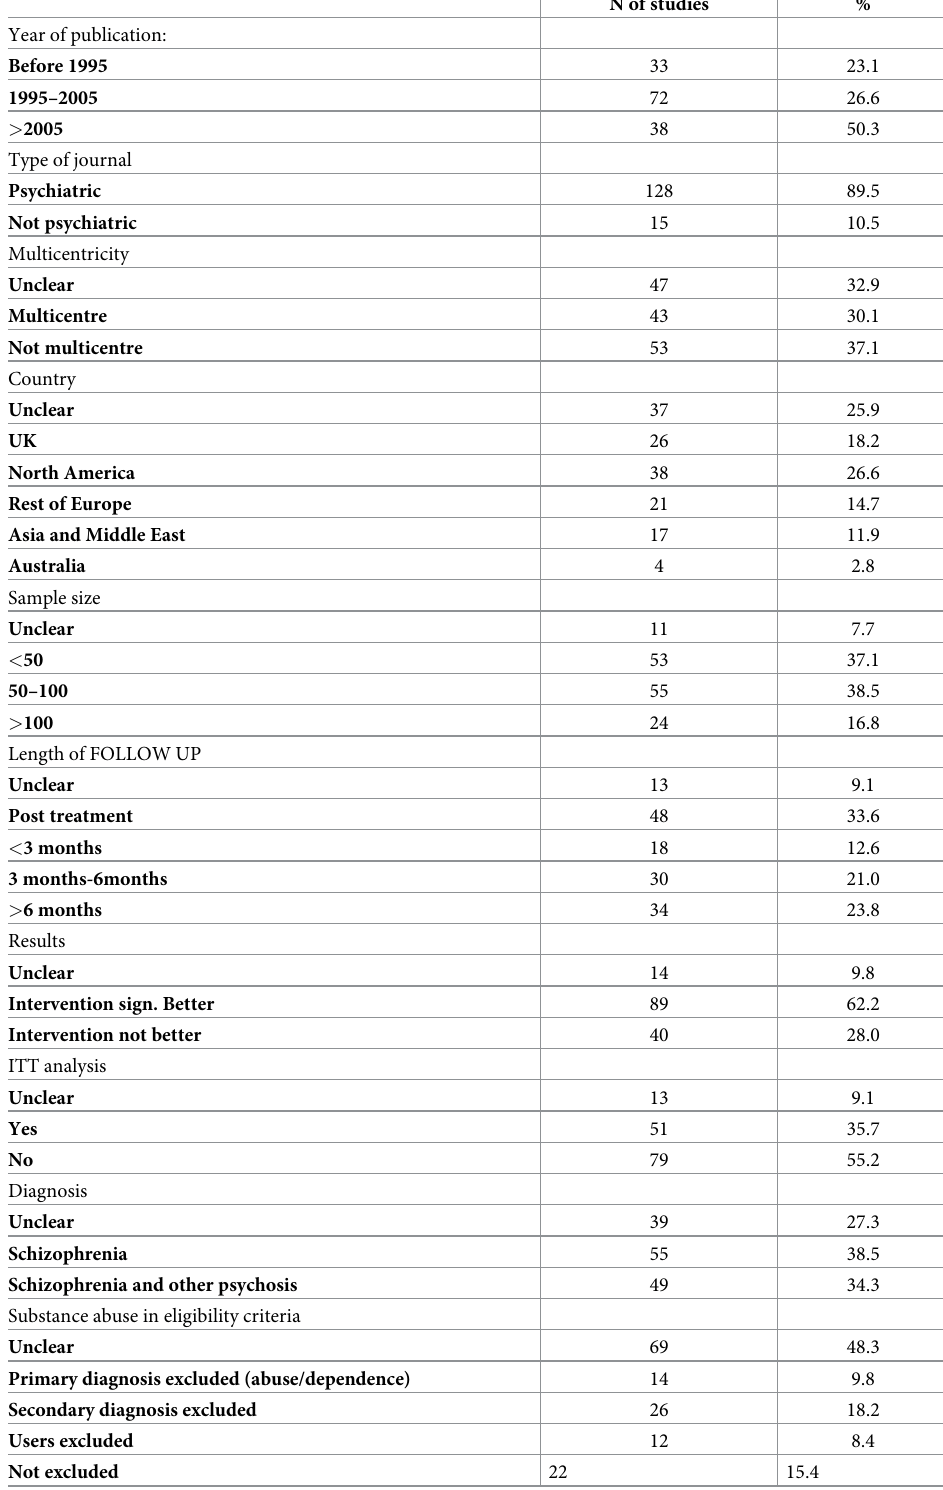
Table 1. Characteristics of included